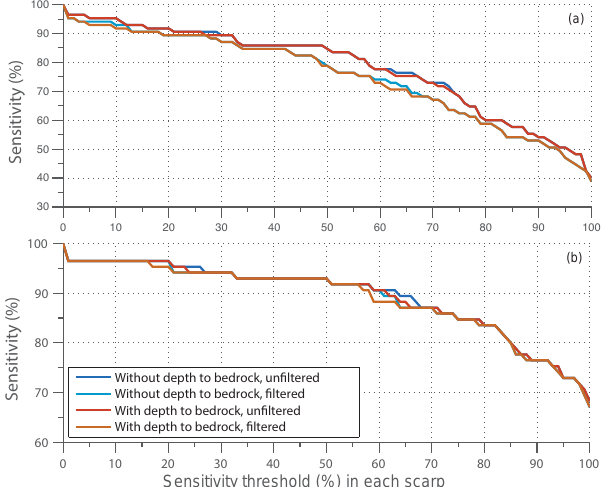
Figure 6. Threshold-based sensitivity curves showing the effect of the depth to bedrock data and the filtering procedure on the areas prone to landslides with cross-sectional angle threshold equal to 1 : 8 (a) and equal to 1 : 22 (b) .